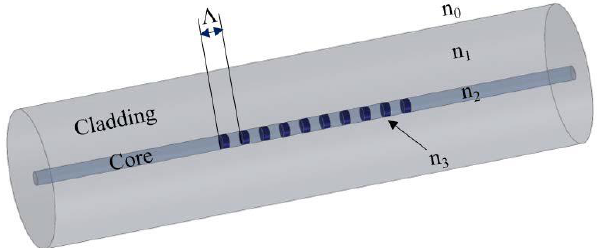
Figure 1. Schematic drawing of a Fiber Bragg Grating (FBG) structure in the core of an optical fiber.